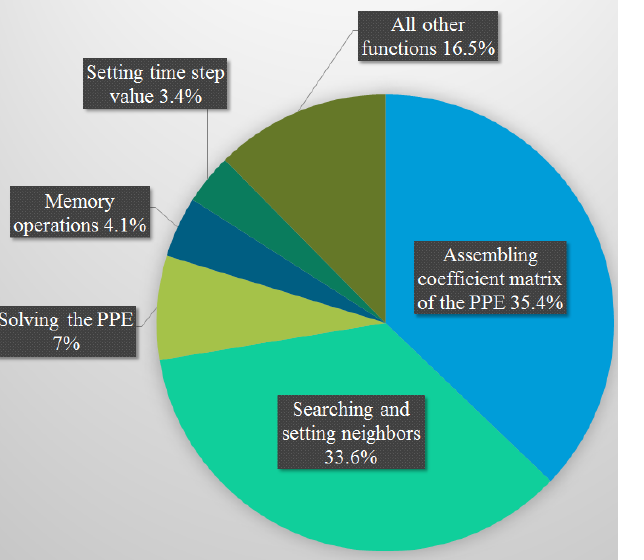
Fig. 11: Functions relative execution time in the GPU